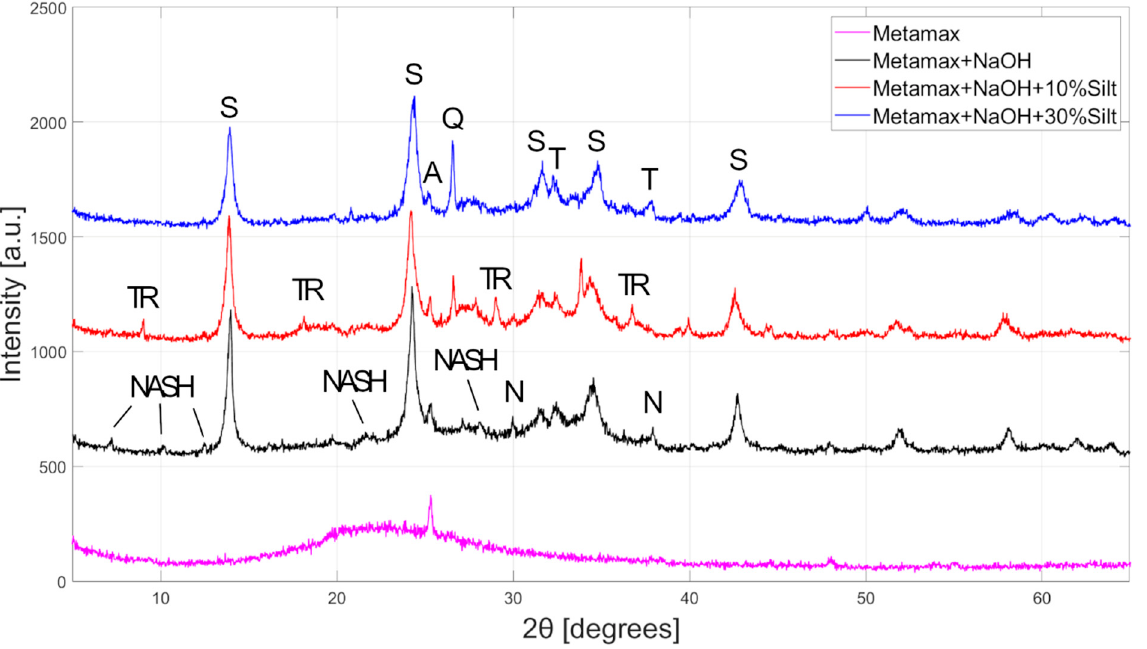
Figure 4. XRD patterns of metakaolin Metamax (magenta pattern) and of samples 4, 5 and 6, made with Metamax, 12 M NaOH solution and 0% (black pattern), 10% (red pattern), and 30% (blue pattern) of waste silt, respectively. Q = Quartz; A = Anatase; S = hydrated Sodalite; NASH = Sodium Aluminum Silicate Hydrates; T = Thermonatrite; N = Natrite; TR = Trona.